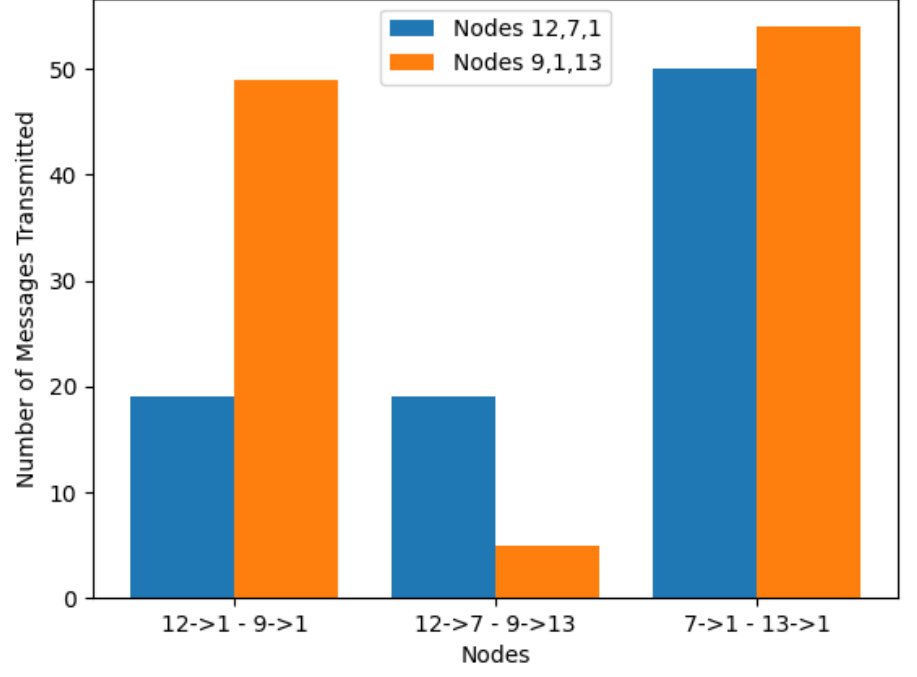
Figure 6. Number of messages transmitted nodes 12,7,1 and nodes